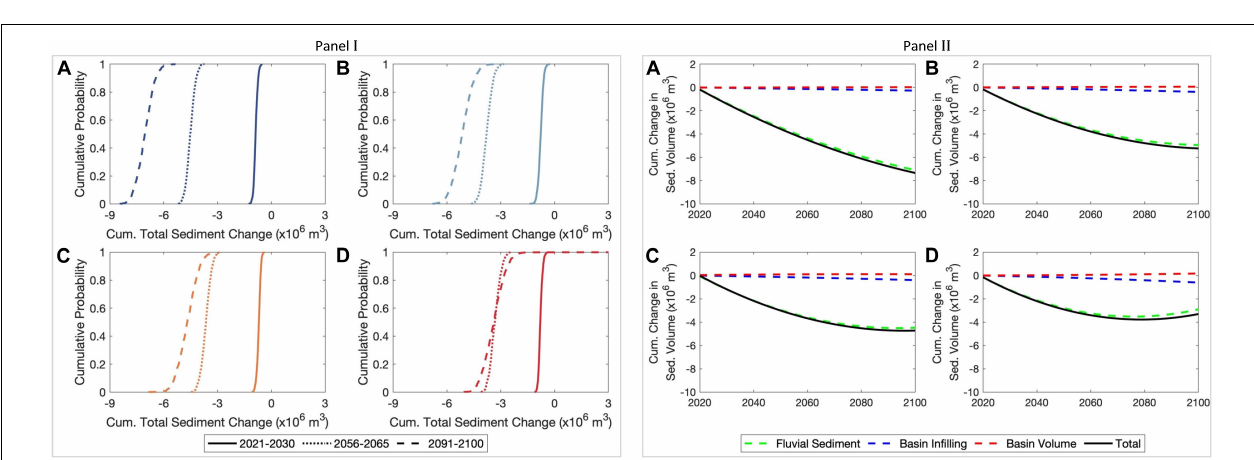
FIGURE 10 | Projected variation of change in total sediment volume exchange ( (cid:49) V T ) between the Kalutara estuary and the adjacent coast over the 21 st century. The projected ranges between 10 th and 90 th percentile are shown as shaded bands with the variation of the 50 th percentile values indicated by the solid lines for RCP 2.6 (blue) and RCP 8.5 (red). The negative volumes indicate that the estuary traps more sediment at the expense of the open coast. Deterministic projections of (cid:49) V T presented in Bamunawala et al. (2020) for RCP 2.6 (blue) and RCP 8.5 (red) are indicated by the dashed lines. Vertical bars indicate the projected ranges between the 10 th and 90 th percentiles in 2100 for all RCPs with the 50 th percentile values indicated as horizontal lines.